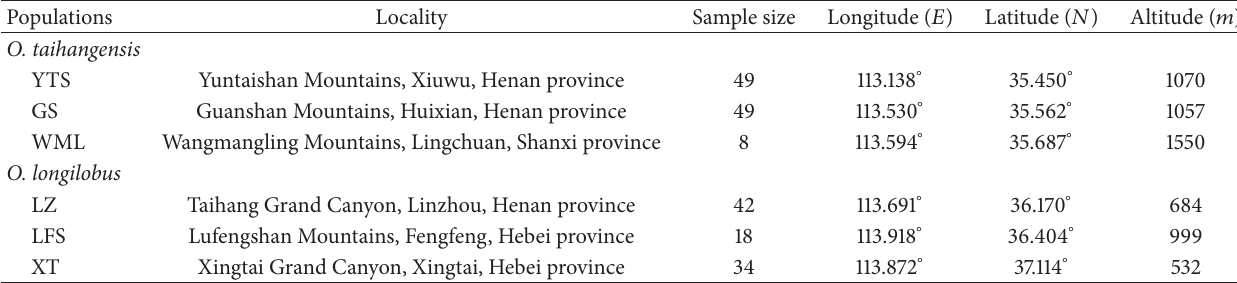
Table 1: Locations of six natural populations in Opisthopappus Shih.